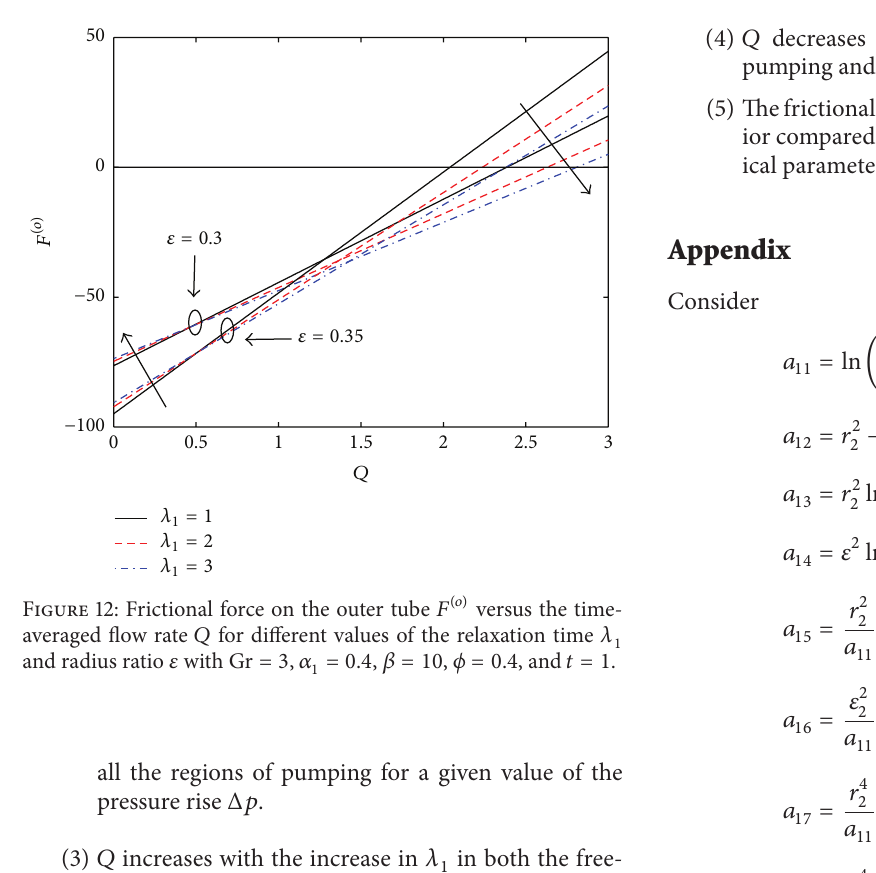
pressure rise Δ𝑝 .